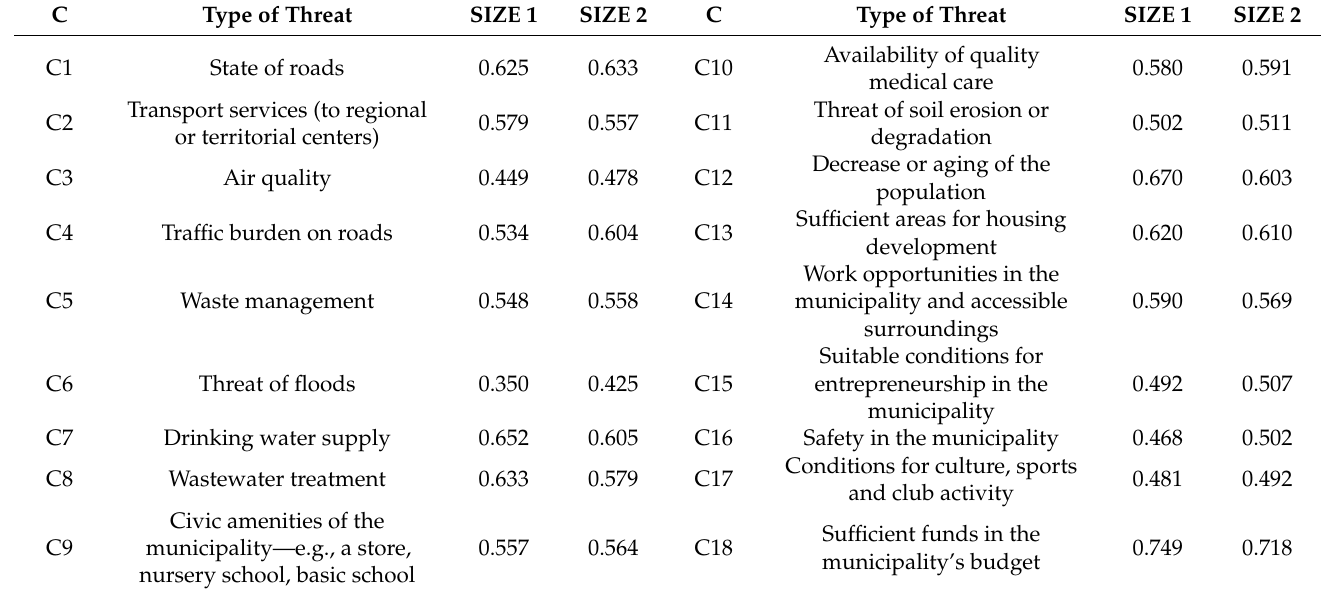
Table 6. Issues of municipalities‘ further development: average values of development threat indicators.